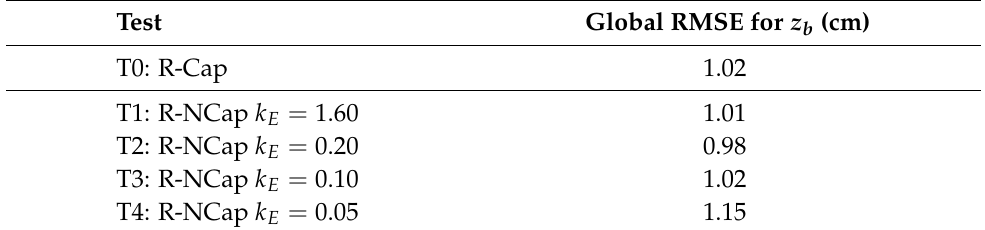
Table 7. Global RMSE for the bed level z b with R-Cap and R-NCap models.